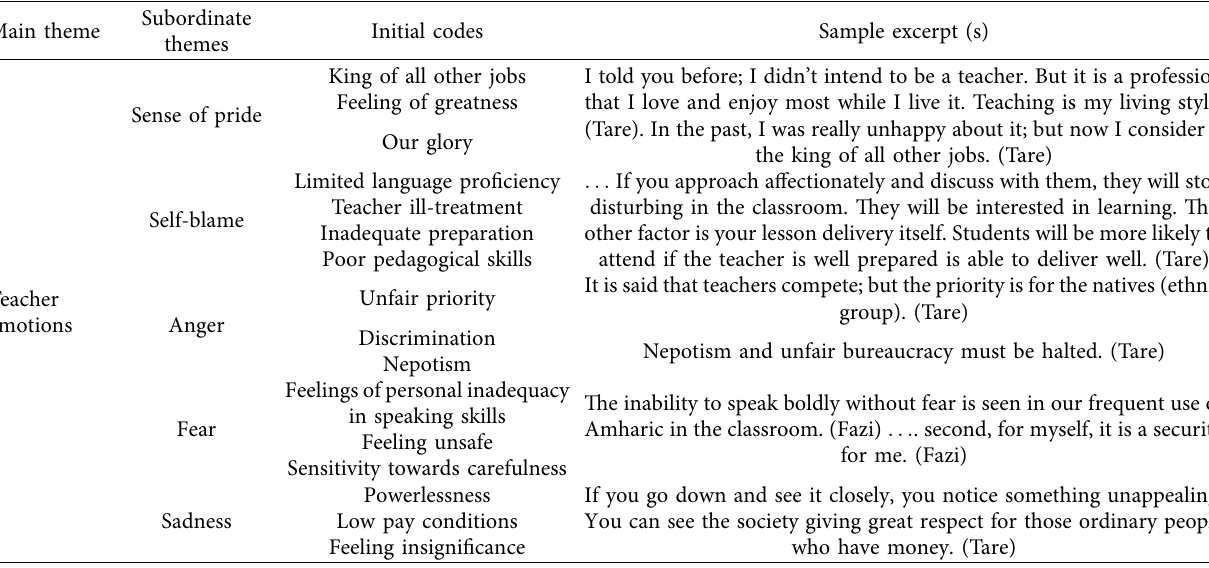
Table 2: Social spaces and personal values engendering teacher emotional